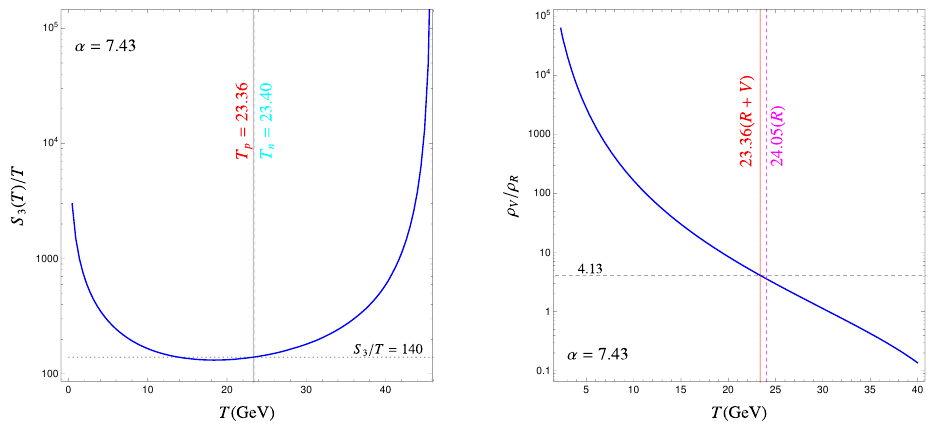
Figure 3 . The details of a super strong EWPT with (cid:11) = 7 : 43. The left panel shows the 3- dimensional Euclidean action of the critical bubble divided by T as T drops. T n (cyan dashed vertical line) is obtained at S 3 =T = 140, corresponding to the intersection between the blue curve and the horizontal dotted line. The percolation temperature T p is also shown with the vertical red line. The right panels shows the (cid:26) V (cid:1) V normalized by the total radiation energy density (cid:26) R (cid:17) for this benchmark. Here the red vertical line corresponds to T p and the slightly higher (magenta dashed line) is obtained by simply neglecting (cid:1) V in the Hubble expansion rate. Here \R" and \V" denote the contribution of radiation and vacuum energy density